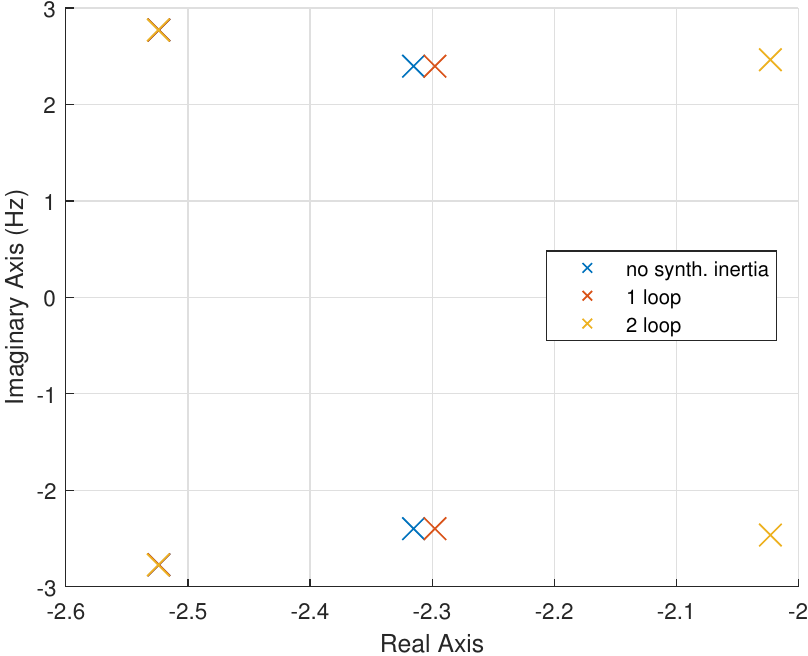
Figure 5. Pole-plot of dominant eigenvalues for ∆ ω modes—scenario 1. The cluster to the left shows the local-area mode which remains unchanged by different control strategies.